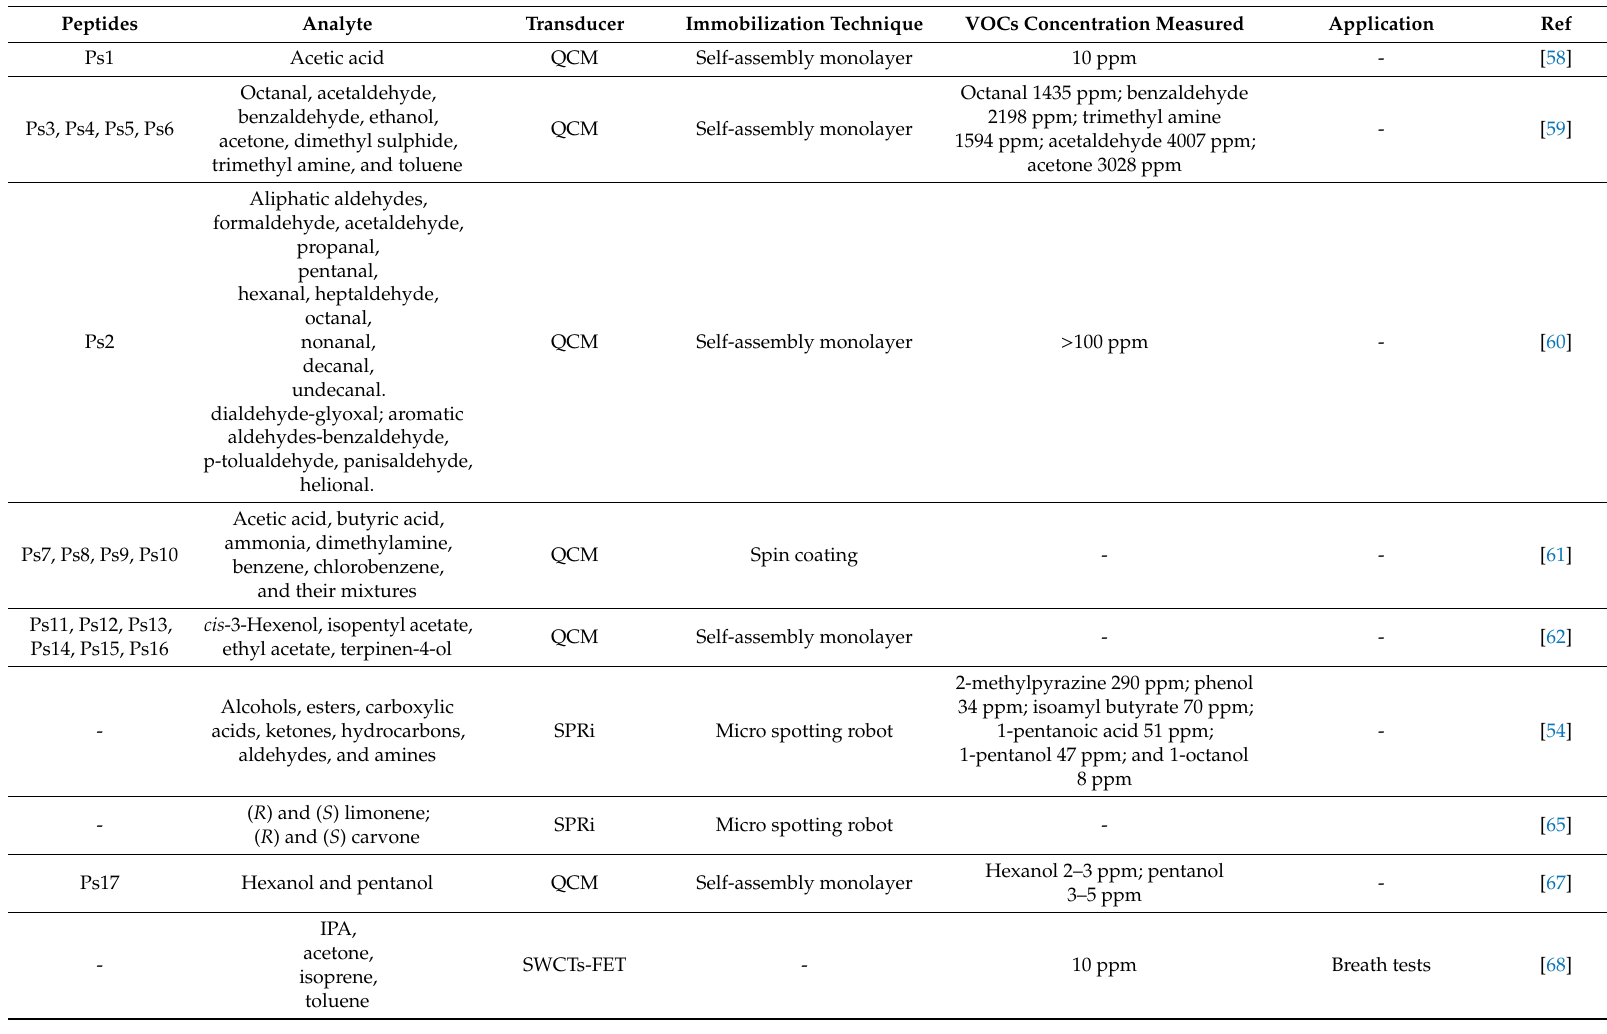
Table 1. Gas sensors equipped with peptides sequences: main features and